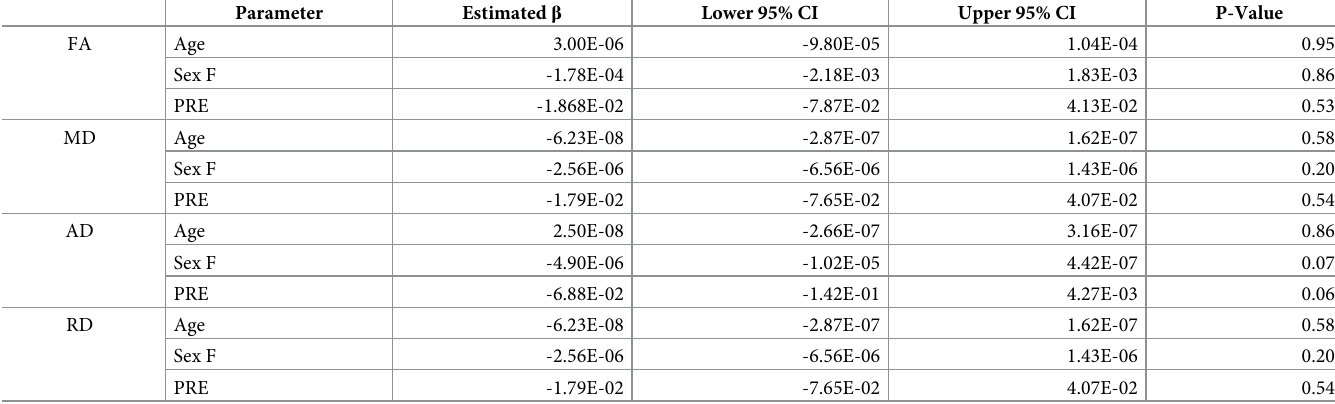
Table 3. Multiple linear regression was used to investigate the relationship between age and sex and the change in the DTI metrics (FA, MD, AD, RD), calculated as the value at 40 minutes after induction of anesthesia minus the baseline awake